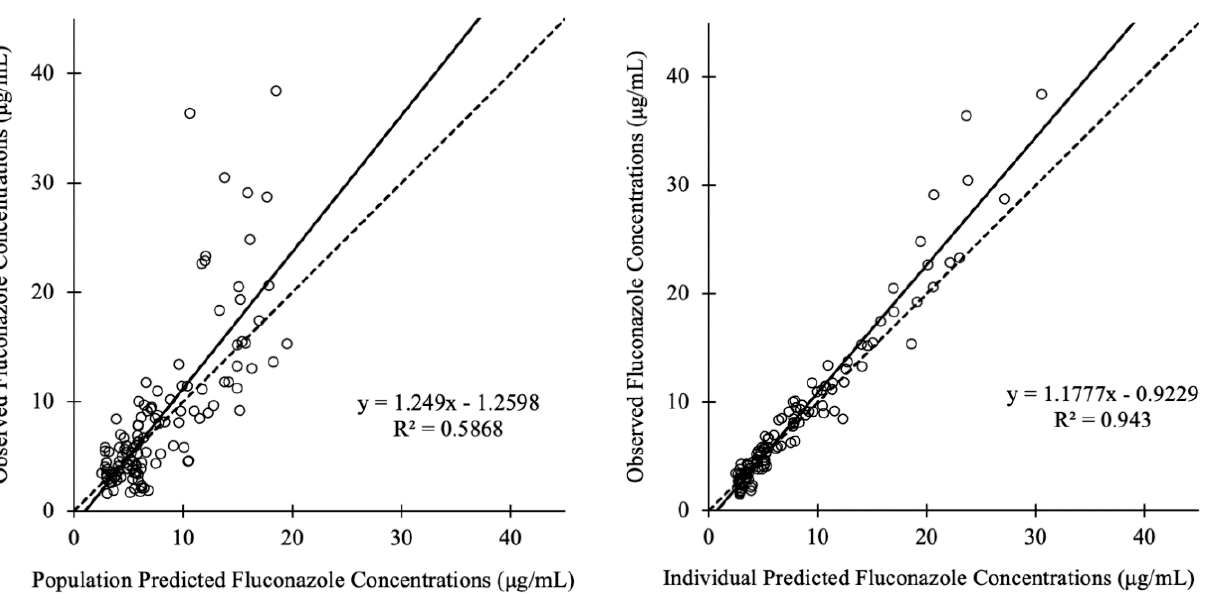
Figure 1. Diagnostic plot for the final covariate model. Figure 1 shows the ( a ) observed versus population-predicted concentrations and ( b ) observed versus individual-predicted concentrations in plasma. Solid lines refer to the linear regression between the observed and predicted concentrations. Dashed lines represent the identity lines between the observed and predicted concentrations.